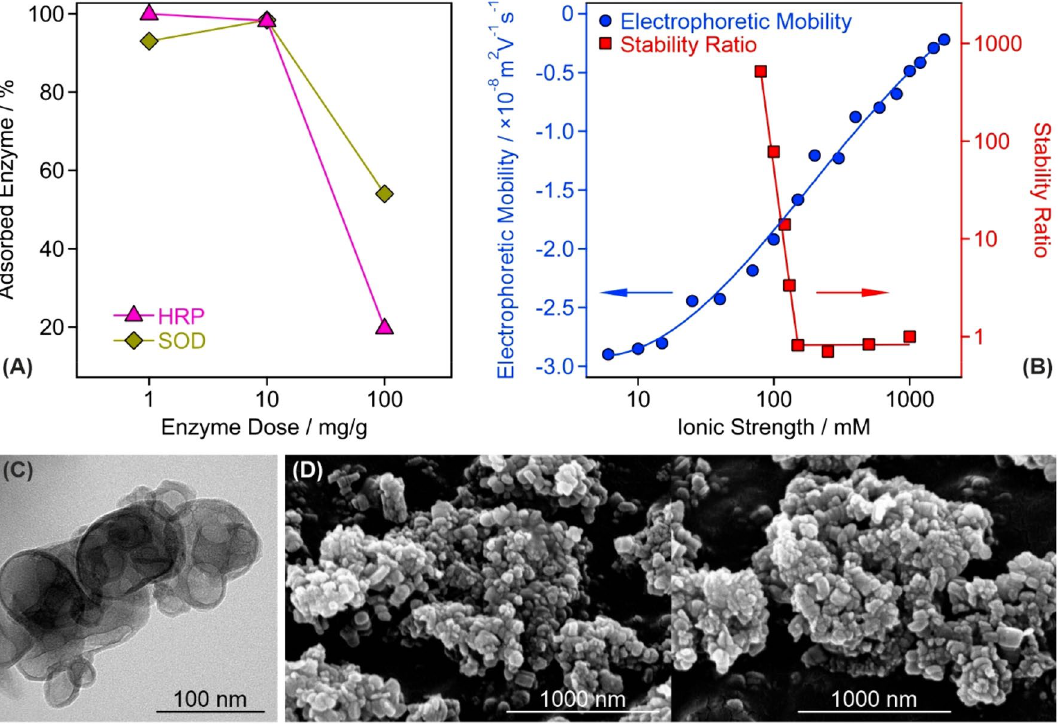
Figure 2. Structural and colloidal features of the CASCADE composite. (A) Partitioning of HRP and SOD enzymes between the bulk and the surface at different enzyme doses. The data indicate that the majority of the added enzyme molecules is adsorbed on the particle surfaces at 10 mg/g dose. (B) Influence of the ionic strength (adjusted by NaCl) on the electrophoretic mobility and stability ratio values of the CASCADE particles. For the latter, the critical coagulation concentration, the threshold value, which separates fast and slow aggregation regimes, was found to be 150 mM. (C) TEM and (D) SEM images of the obtained hybrid material. In (A,B) the solid lines serve to guide the